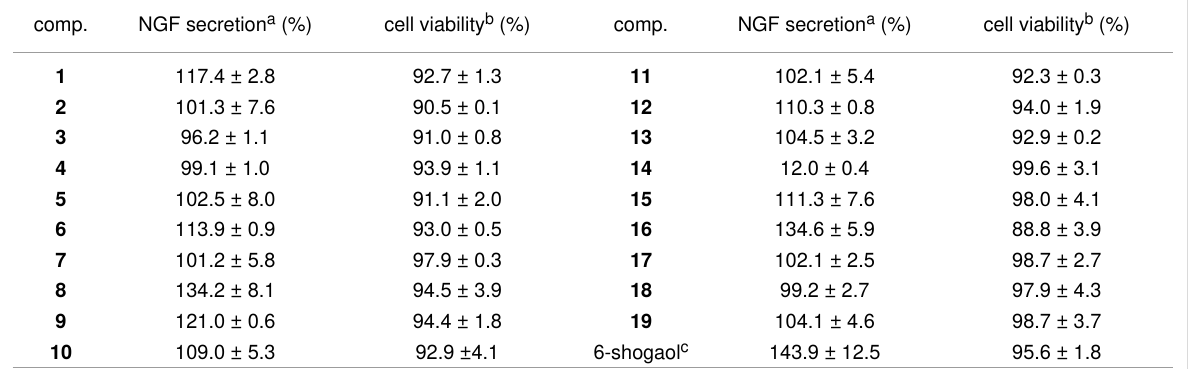
Table 4: Effects of isolated compounds on NGF secretion in C6 cells.